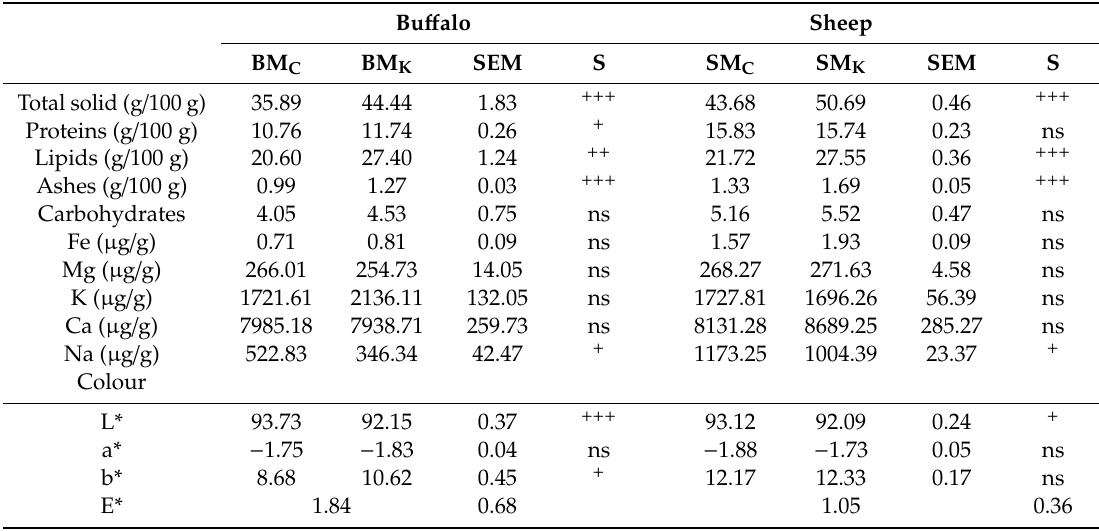
Table 2. Physico-chemical composition of the cheeses made with kiwi extract or calf